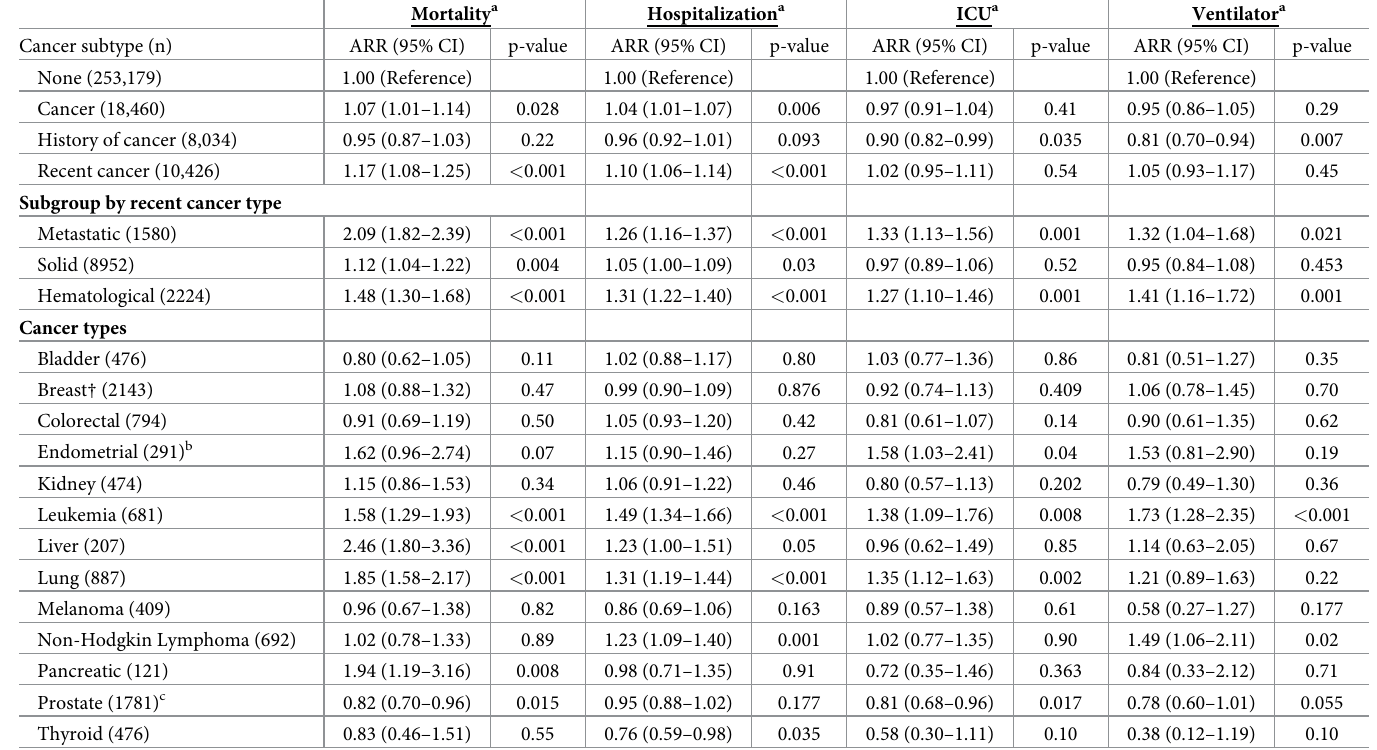
Table 2. COVID-19 outcomes by cancer status and